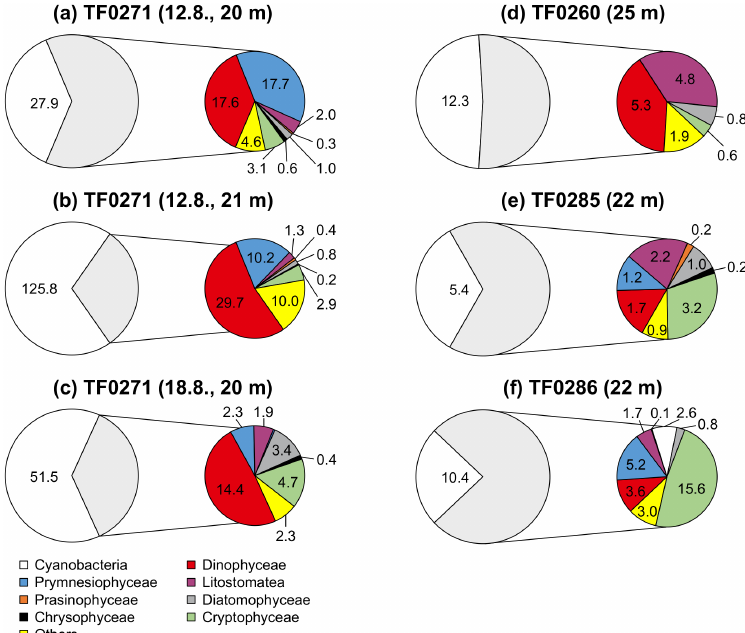
Figure 9. Phytoplankton community composition within the subthermocline chlorophyll a maximum (mgCm − 3 ) at three stations with a distinct subthermocline methane enrichment (a–e) and at one station without a distinct enrichment (f) . The grey shaded non-cyanobacteria community is described in detail in the coloured circles. Three replicate samples were taken at TF0271 in a period of 7 days (a–c) showing that the prevalence of Dinophyceae below the thermocline is a consistent feature at this station.